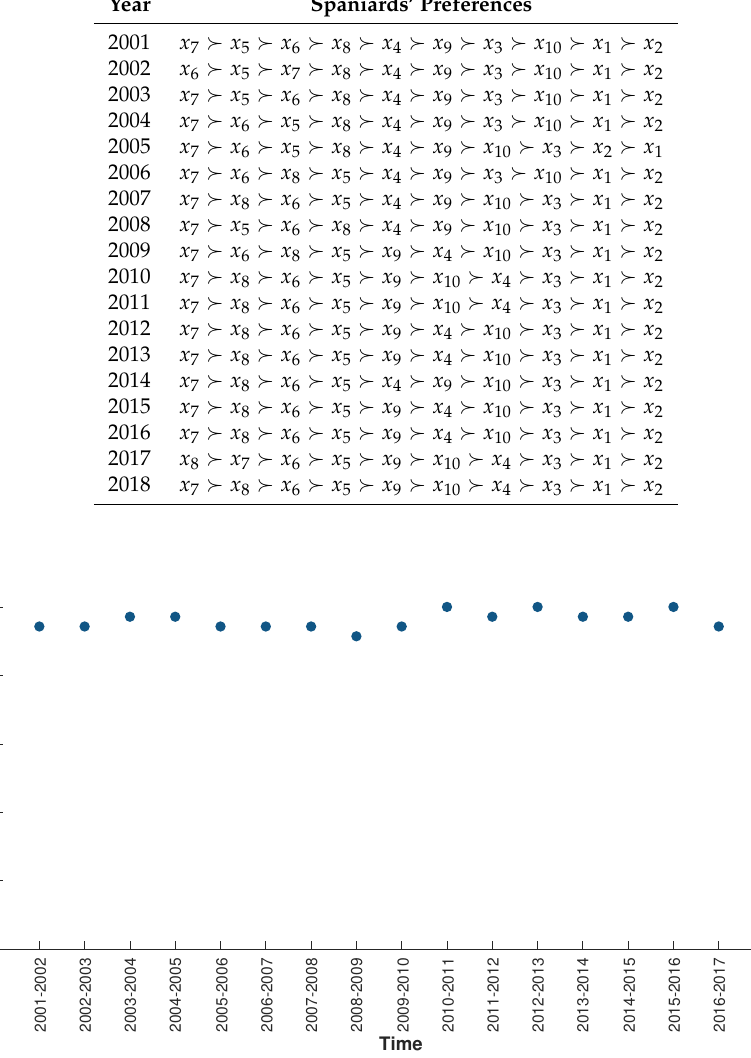
Figure A7. Graphic illustration of the local decision stability measures obtained for the entire society for Question 2. Table A7. Global stability measures for Spaniards’ preferences attending to several values of λ for Question